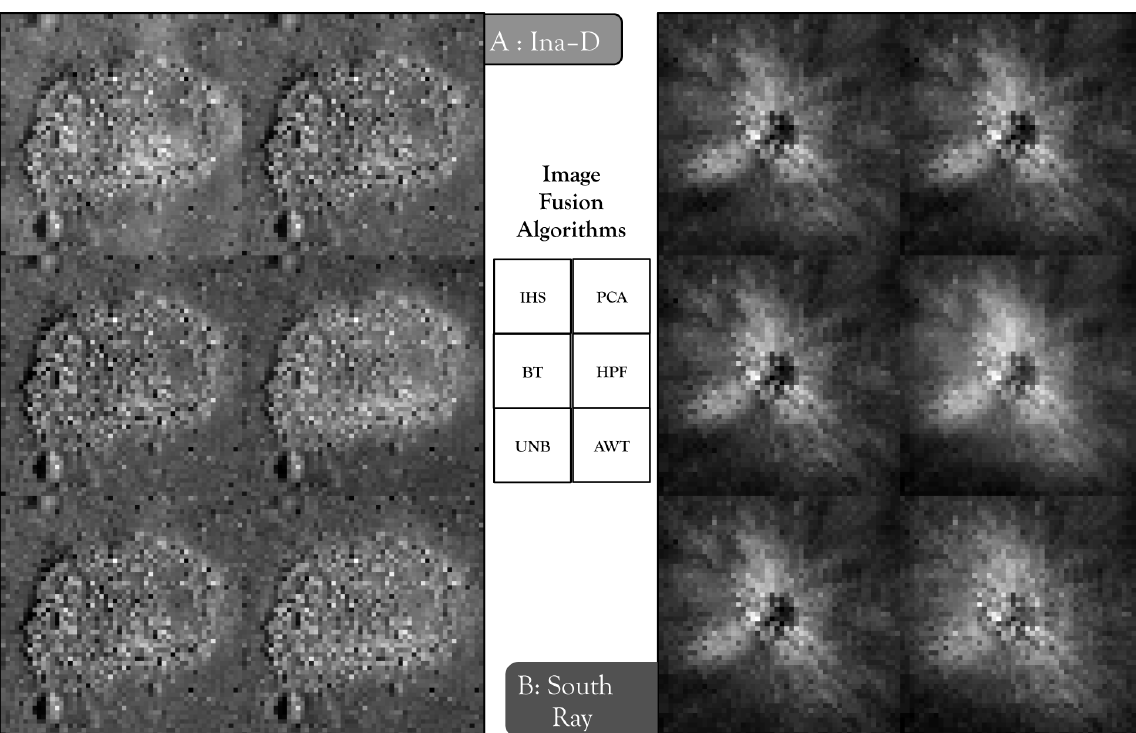
Figure 5: Image fusion results for LROC WAC UV 1